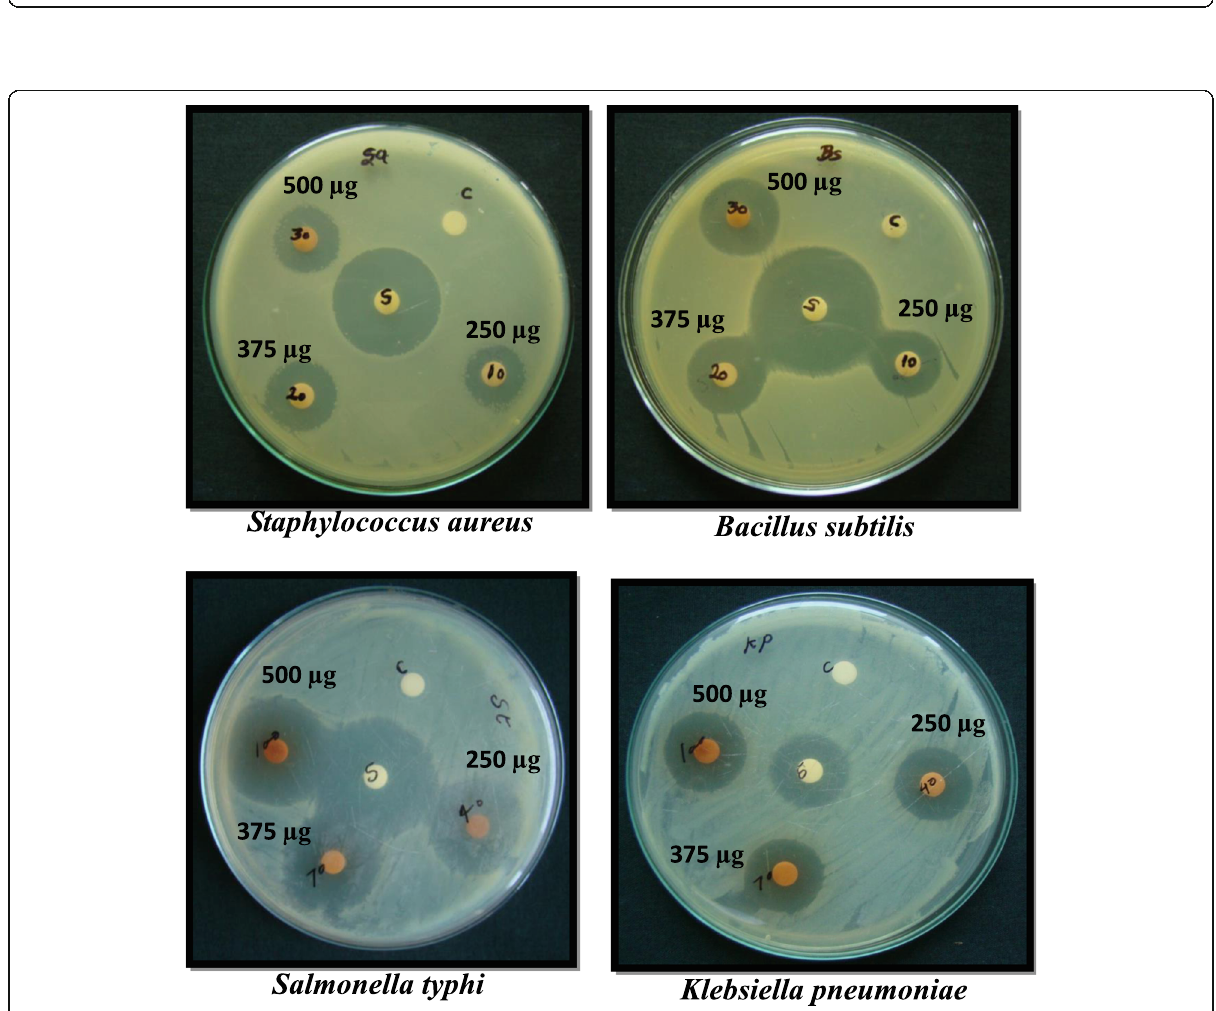
Fig. 5 Antibacterial activity of root extract of S. heyneanus against four different bacterial species by disc diffusion tests. S, standard; C, negative